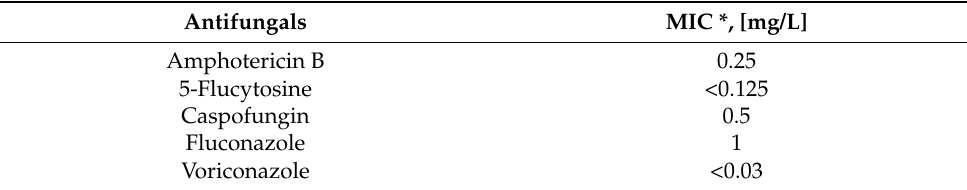
Table 1. Antifungal susceptibility profile of S. cerevisiae clinical isolate studied herein.